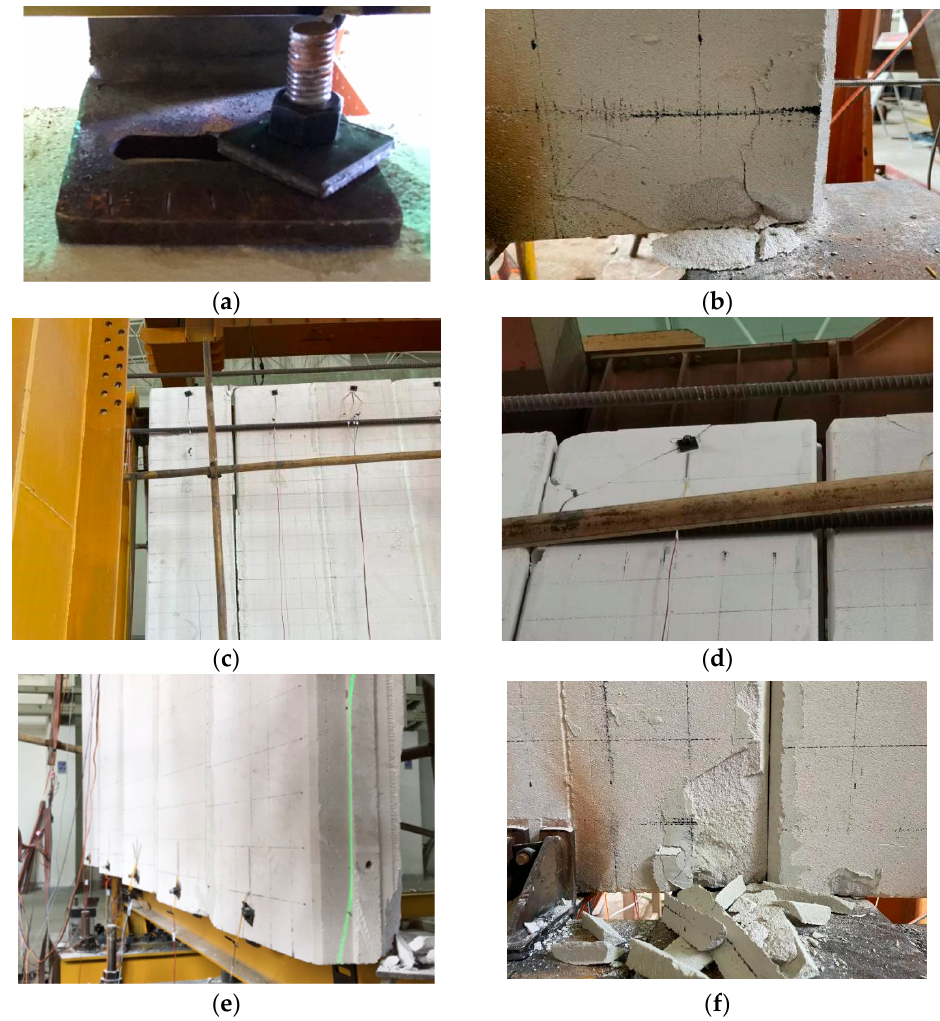
Figure 9. Experimental results of SFW2: ( a ) upper connector slipped within bolt hole; ( b ) corner panel was broken; ( c ) splicing mortar broke and relative movement; ( d ) cracks appeared at the upper bolt holes; ( e ) obvious interpanel dislocation; ( f ) corner of the panel back was broken off.